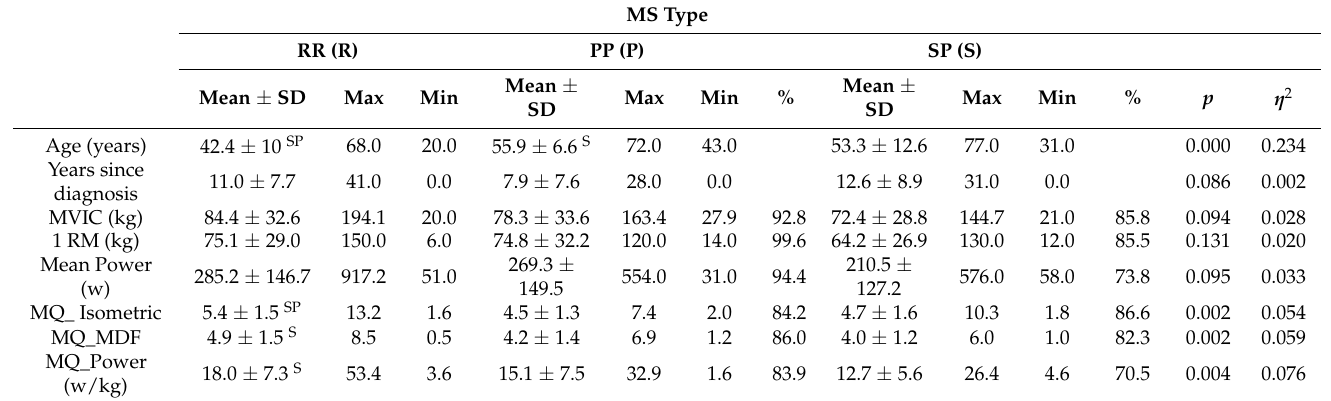
Table 5. Muscle strength and quality values according to the type of MS.